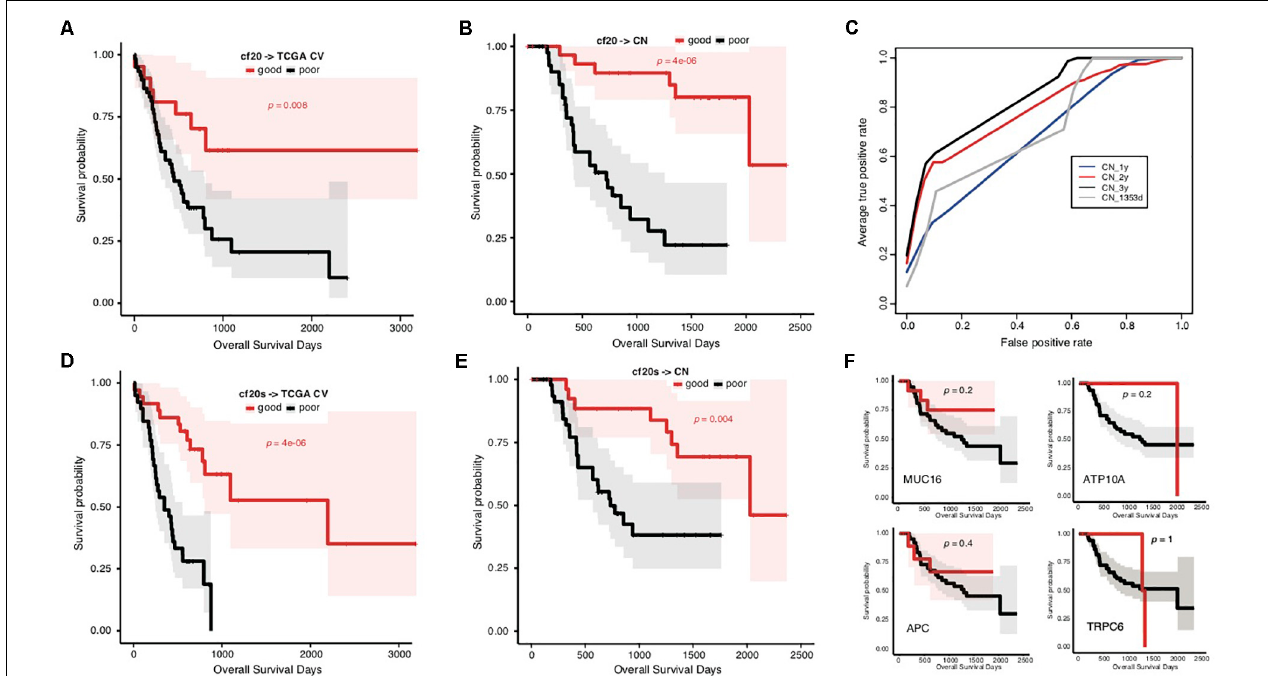
FIGURE 4 | Prediction of STAD prognosis with the genetic models based on 20 common somatic mutation features. (A) The Kaplan–Meier overall survival curves of the TCGA STAD cases classified by cf20 with a 5-fold cross-validation strategy. (B) The Kaplan–Meier overall survival curves of the Chinese STAD cases stratified by the cf20 model. (C) The 5-fold cross-validated ROC curves of cf20 model predicting the prognosis of Chinese STAD cohorts stratified by different cutoff survival time. (D) The Kaplan–Meier overall survival curves of the TCGA STAD cases classified by the cf20s model which was combined 20 common-gene features and TNM stage information. (E) The Kaplan–Meier overall survival curves of the Chinese STAD cases stratified by the combined cf20s model. (F) The Kaplan–Meier overall survival curves of the Chinese STAD cases stratified by models based on example individual genes, including MUC16, ATP10A, APC, and TRPC6.